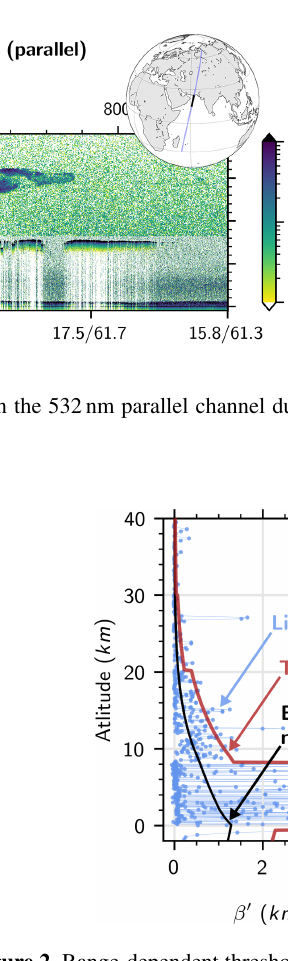
Figure 2. Range-dependent threshold (red) applied to a single-shot lidar signal profile (blue) in clear sky during nighttime. The esti- mated molecular signal is shown in black. Jumps in the lidar signal and threshold at − 0 . 5, 8.2 and 20.2km reveal the change of onboard averaging